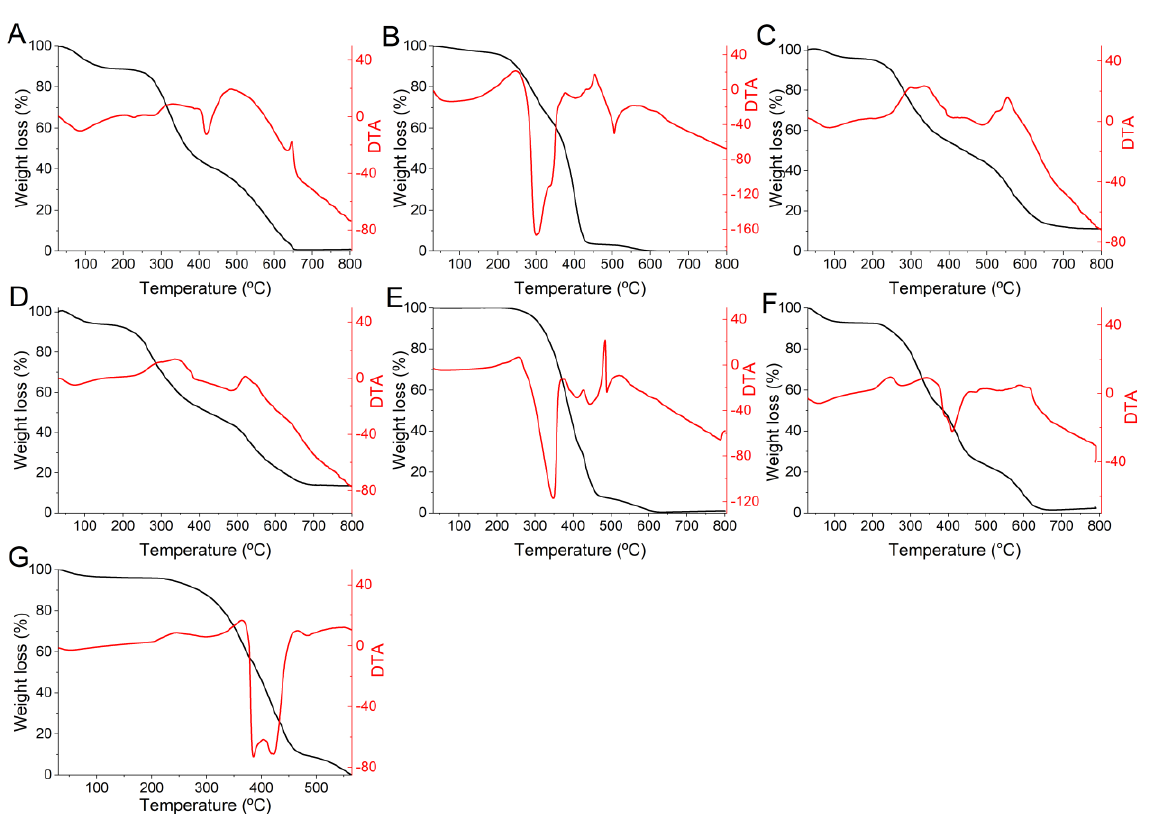
Figure 3. Thermograms and DTA of the encapsulating and encapsulated materials obtained by O/W emulsification. ( A ) Porcine gelatin; ( B ) Tween 20; ( C ) L. acidophilus ; ( D ) L. plantarum ; ( E ) corn oil; ( F ) LAEG — L. acidophilus in gelatin; ( G ): LPEG — L. plantarum in gelatin.